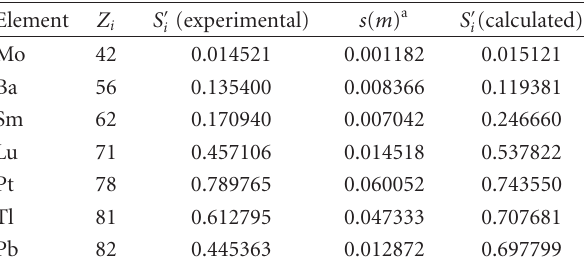
Table 3: Experimental and calculated mean relative sensitivity, S (cid:3) i , and mean standard deviation for chemical elements emitting X-L rays for 42 ≤ Z i ≤